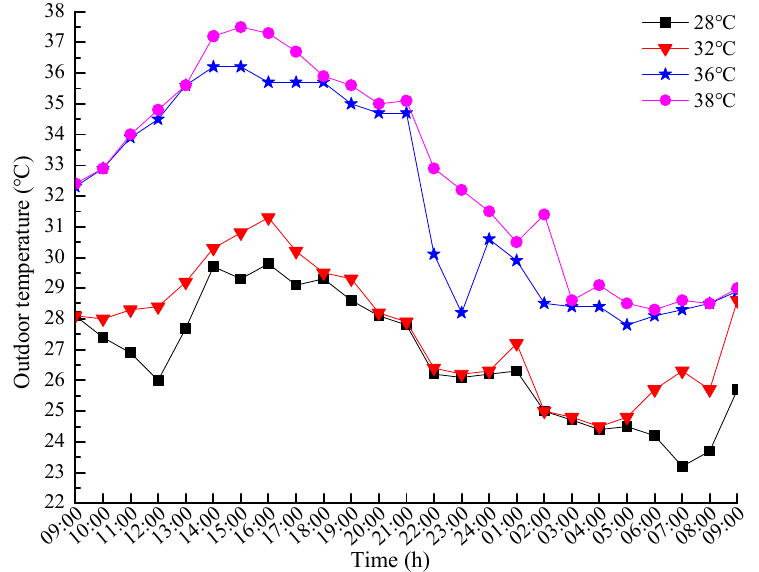
Figure 2. The hourly outdoor temperature of the four temperature conditions.